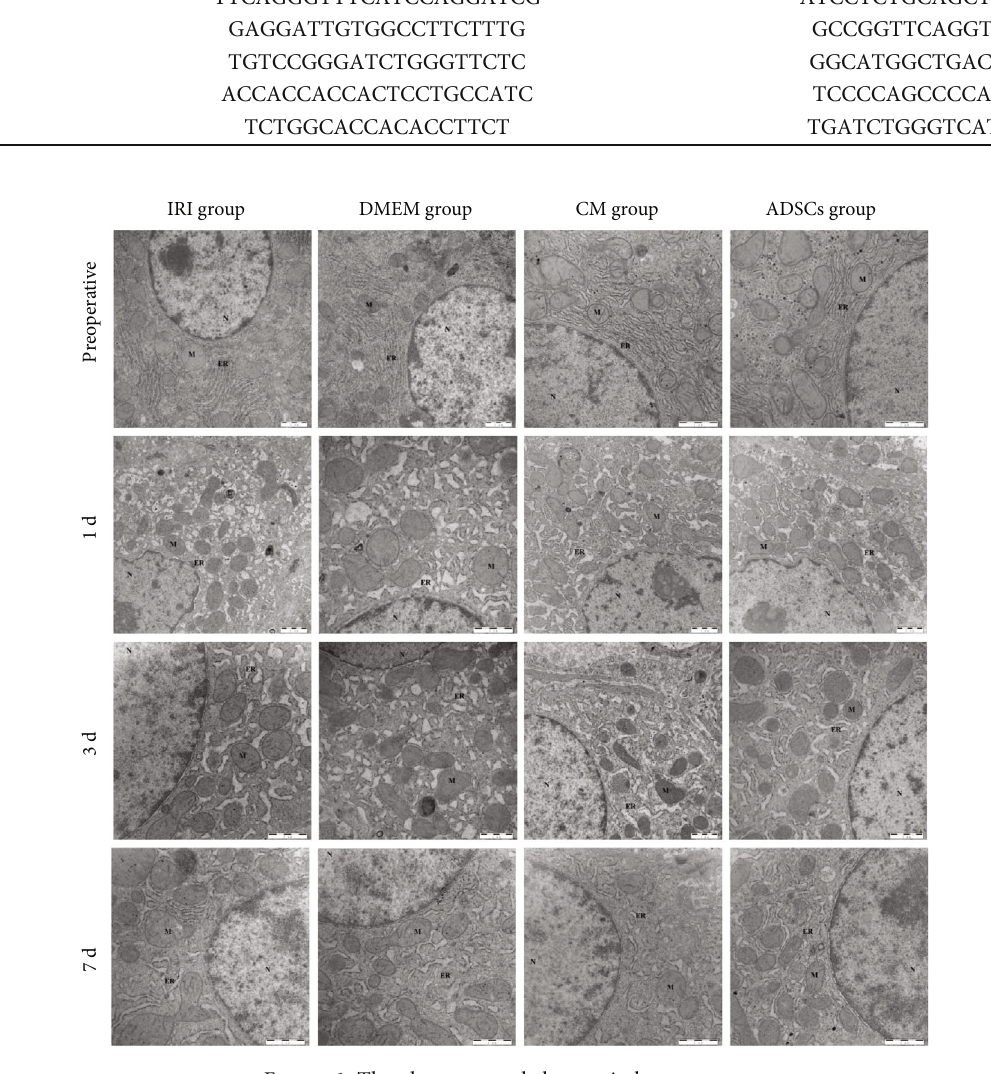
Figure 1: The ultrastructural changes in